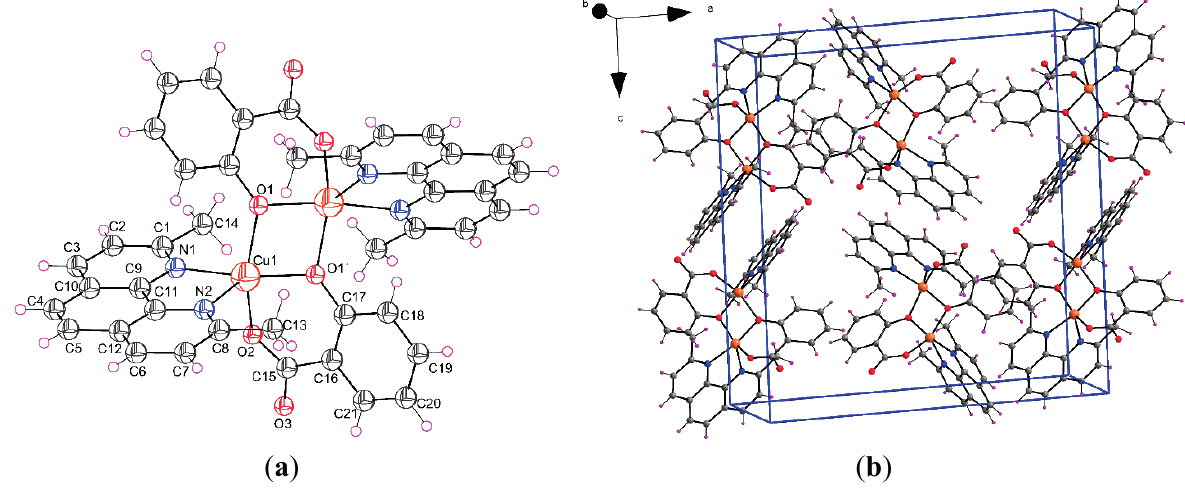
Figure 3. ( a ) Perspective view of complex 2 , with the atom numbering scheme. Thermal ellipsoids are drawn at the 50% probability level (symmetry code i: − x , y , 1/2 − z ); ( b ) View of the packing of 2 in the unit